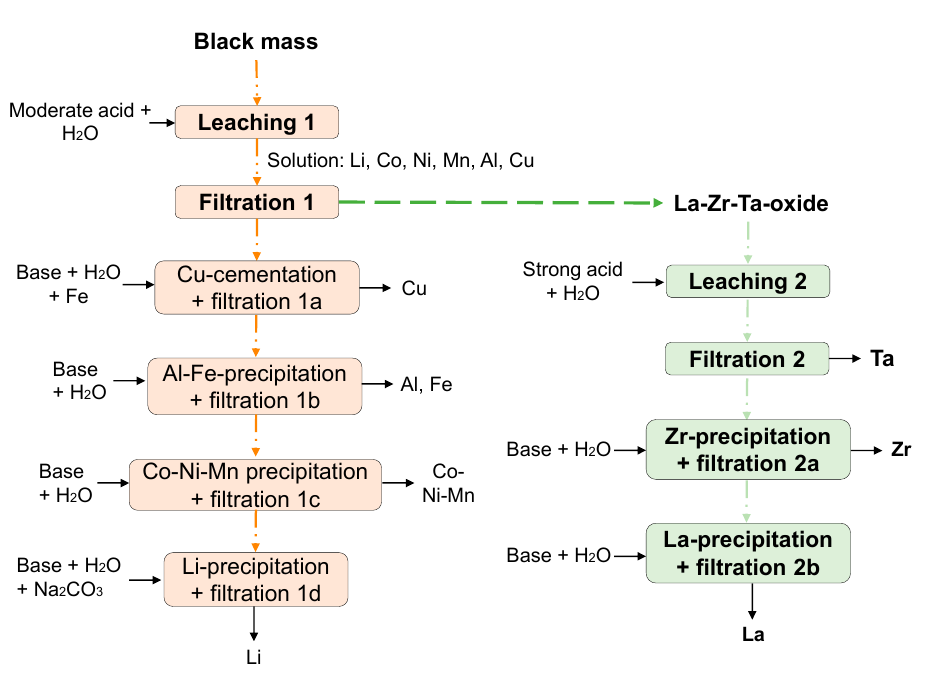
Figure 12. Developed recycling path for multi-step hydrometallurgy (Scenario 2: No dissolution of garnet structure → moderate leaching).